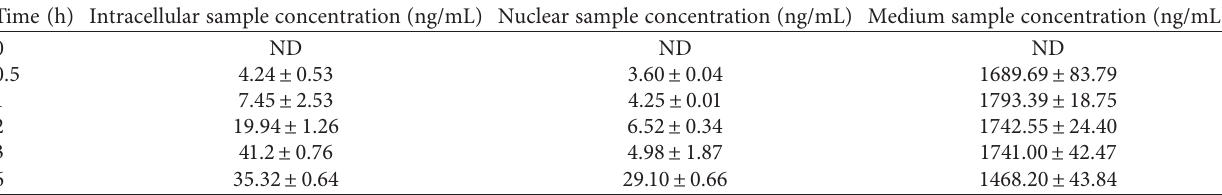
Table 6: The concentration variations of pemetrexed in medium, cytoplasm, and cell nucleus ( n � 3, mean ±